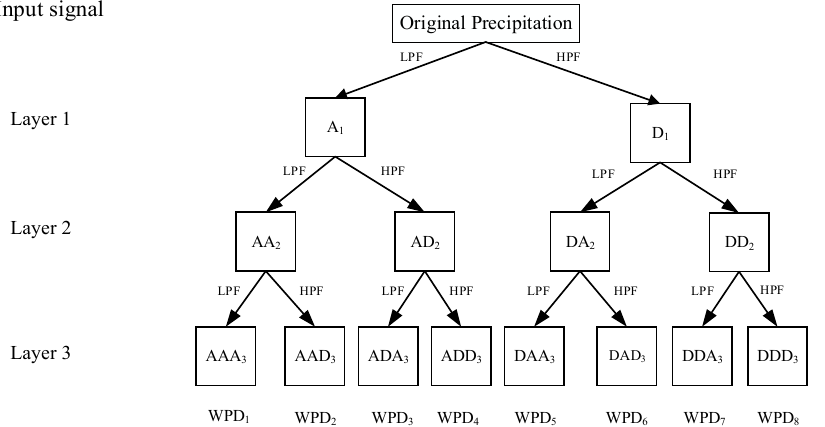
Figure 3. Schematic diagram of the Wavelet Packet Decomposition (WPD) method.